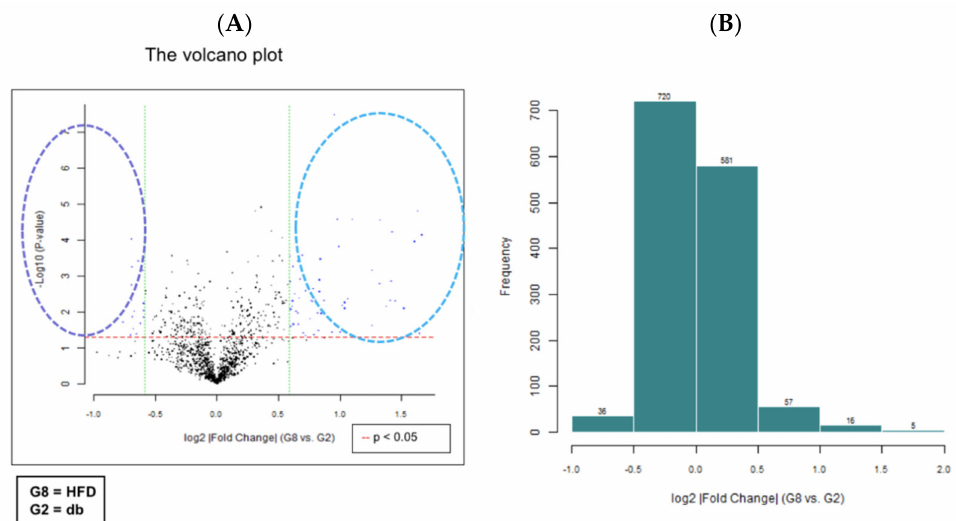
Figure 6. miRNA microarray validation with qRT-PCR analysis in liver tissue samples from grouped HFD-fed db/db mice and standard diet-fed db/db mice. The 6-week-old male db/db mice were fed with HFD for 12 weeks. After euthanization, liver tissue samples were obtained for the determination of miRNA expression. miRNAs were selected from the grouped miRNA microarray dataset and examined through qRT-PCR. The miRNA were sorted on the basis of log2 fold changes in miRNA expression and were represented as horizontal bars (red line in figure). ( A ) The volcano plot of liver miRNA expression in HFD (G8) versus db (G2). Standard selection criteria to identify differentially expressed genes were established at log2 |fold change| ≥ 0.585 and a p -value of < 0.05 (blue dots in figure). ( B ) Histogram of log2 |fold change| (HFD versus db). Error bars represent the standard deviation of the mean ± SD. db, db/db mice fed with standard diet; HFD, db/db mice fed with HFD.